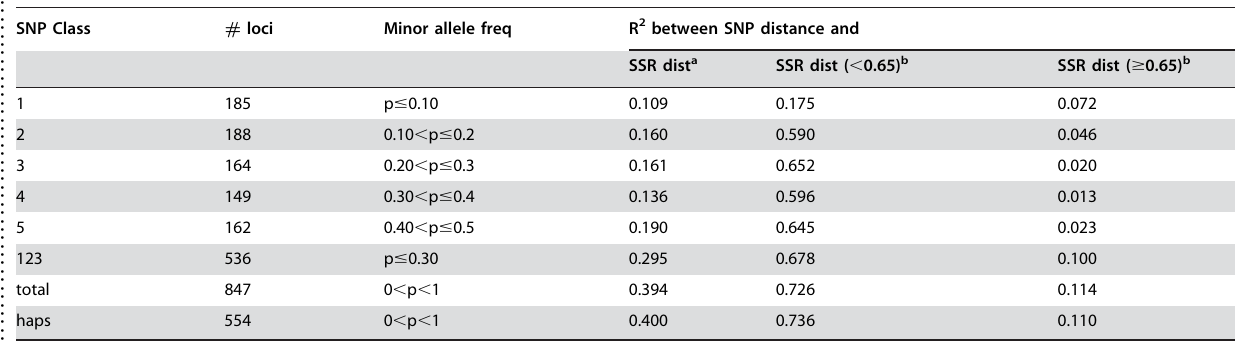
Table 4. Correlation between genetic distance for SSRs and SNPs of different frequency classes. .. ... .... ... ... .... ... ... .... ... ... .... ... ... .... ... ... .... ... ... .... ... ... .... ... ... .... ... ... .... ... ... .... ... ... .... ... ... .... ... ... .... ... ... . SNP Class